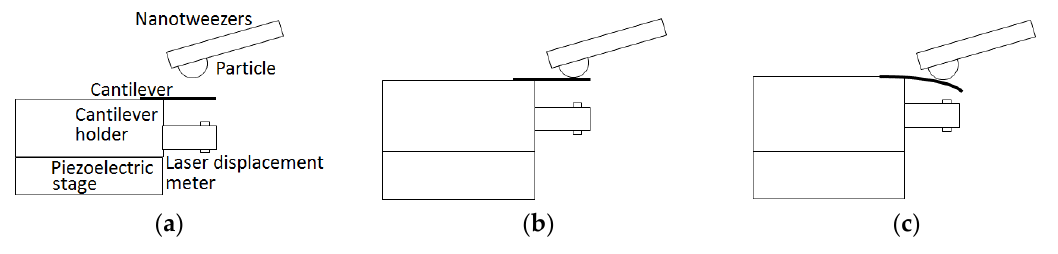
Figure A1. Experimental apparatus for verifying the contact sensing of nanotweezers gripping a particle: ( a ) approach toward particle; ( b ) contact with particle; ( c ) deflection by particle.